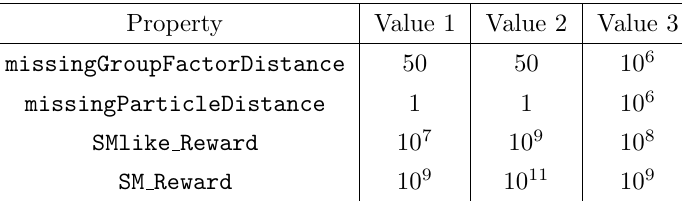
Table 6 . Value assignments for the SM reward